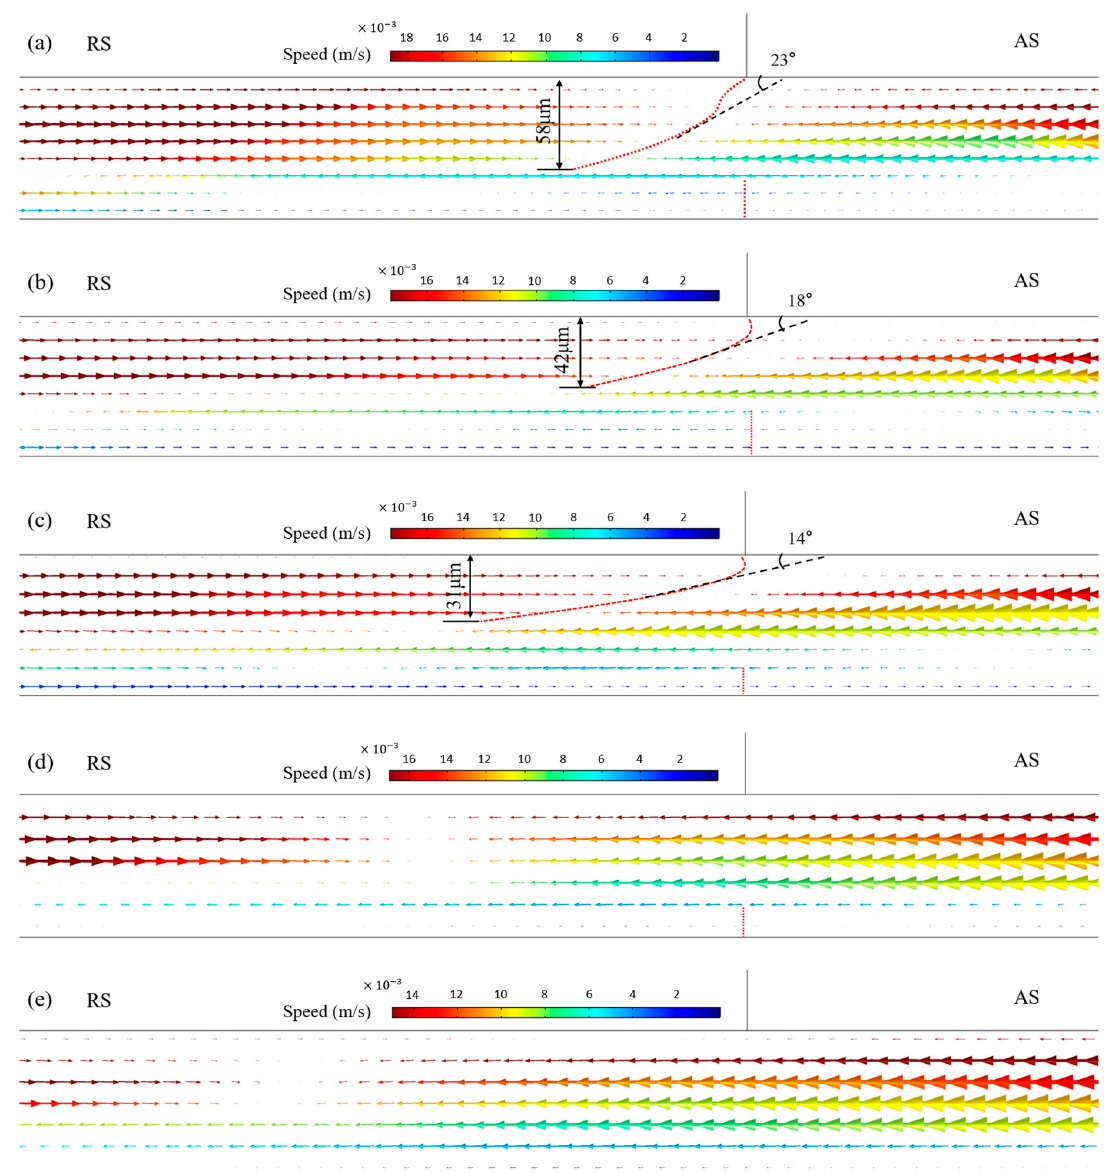
Figure 11. Influence of root welding allowance on plastic metal flow behavior at the root of the welding seam (1000 rpm, 120 mm/min). ( a ) 0.09 mm; ( b ) 0.08 mm; ( c ) 0.07 mm; ( d ) 0.06 mm; ( e ) 0.05 mm.